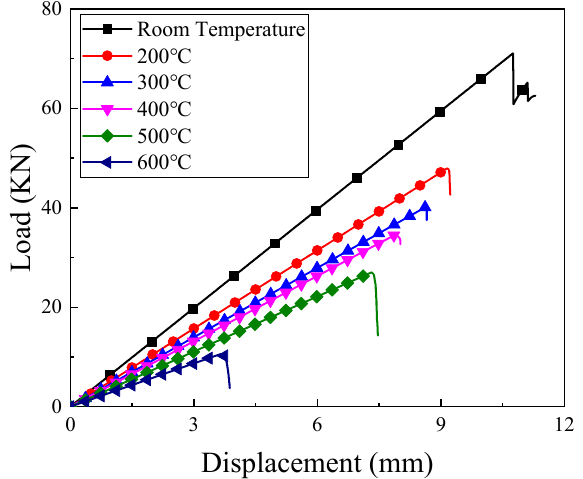
Figure 5. Typical test machine tensile force versus displacement curves at different temperatures.